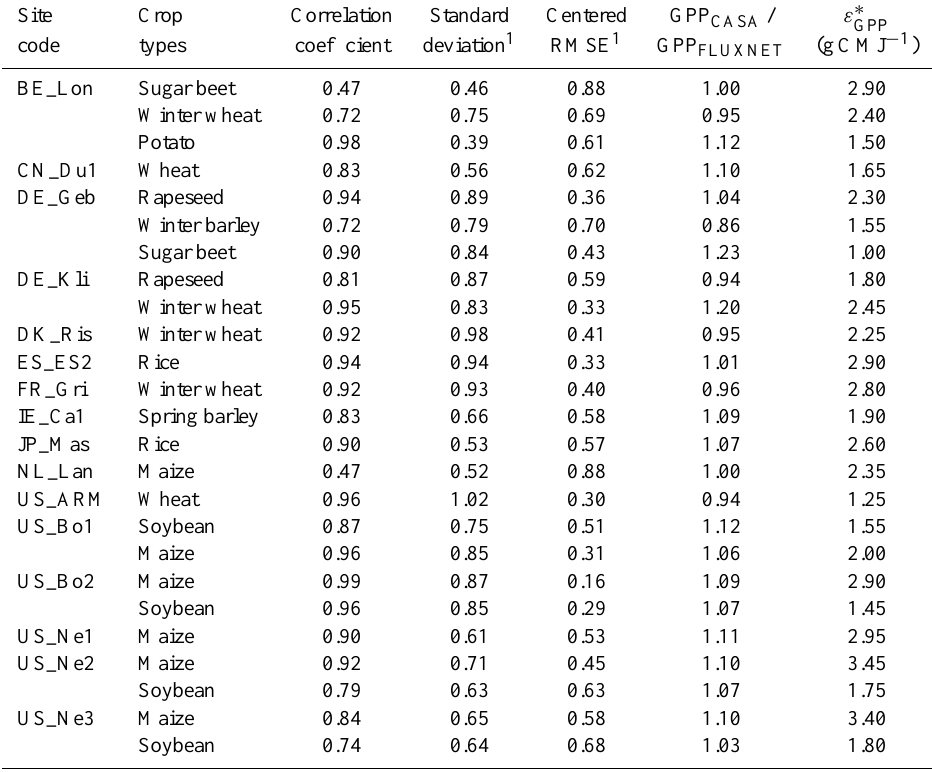
estimates at FLUXNET sites. GPP